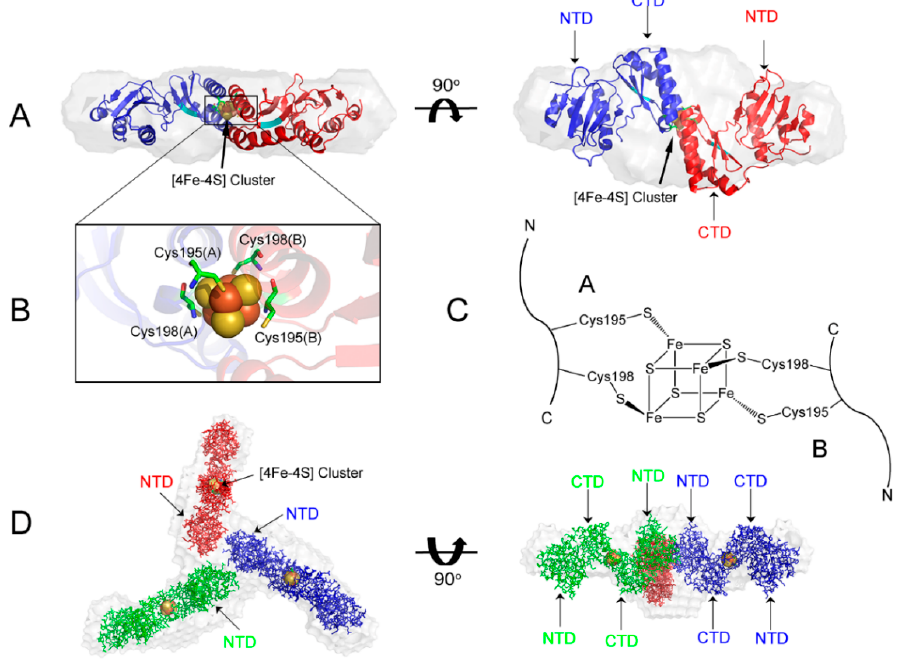
Figure 8. Structural model of [4Fe-4S]-NFU1. ( A ) Rigid body reconstructed model of the [4Fe-4S] cluster-bound dimer of NFU1 superimposed onto the dummy atom model reconstructed from the SAXS data for dimeric apo-NFU1; ( B ) Expansion of the region of the [4Fe-4S] cluster; ( C ) Configuration of cluster ligation consistent with the SAXS results; ( D ) The rigid body reconstructed model of the trimer of cluster-containing dimers of NFU1 superimposed onto the dummy atom model reconstructed from the SAXS data for holo-NFU1. The tripartite binding region is formed by the N-terminal domain of one NFU1 subunit of each of three NFU1-[4Fe-4S]-NFU1 units. The model is consistent with NMR studies. Adapted from Ref. [196] with permission.